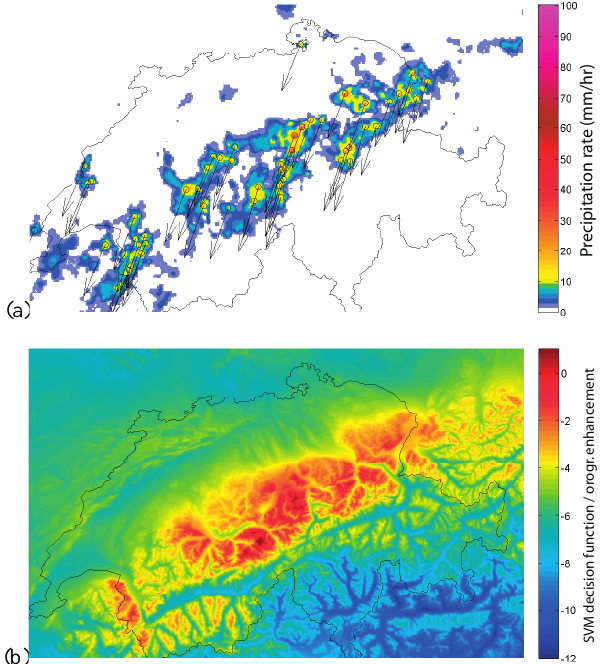
Figure 2. (a) Radar image with the detected cells and (b) the corre- sponding orographic enhancement characterized by the linear one- class SVM decision